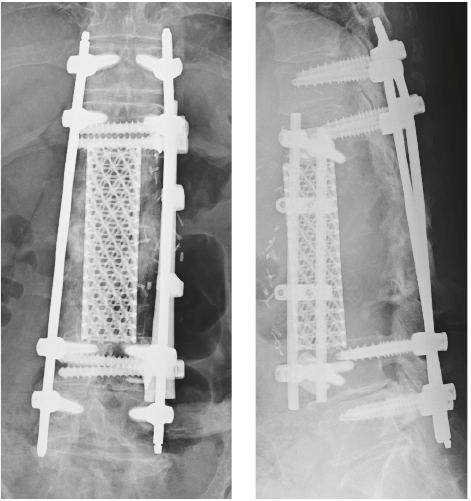
Figure 6: X-ray image of the spine after